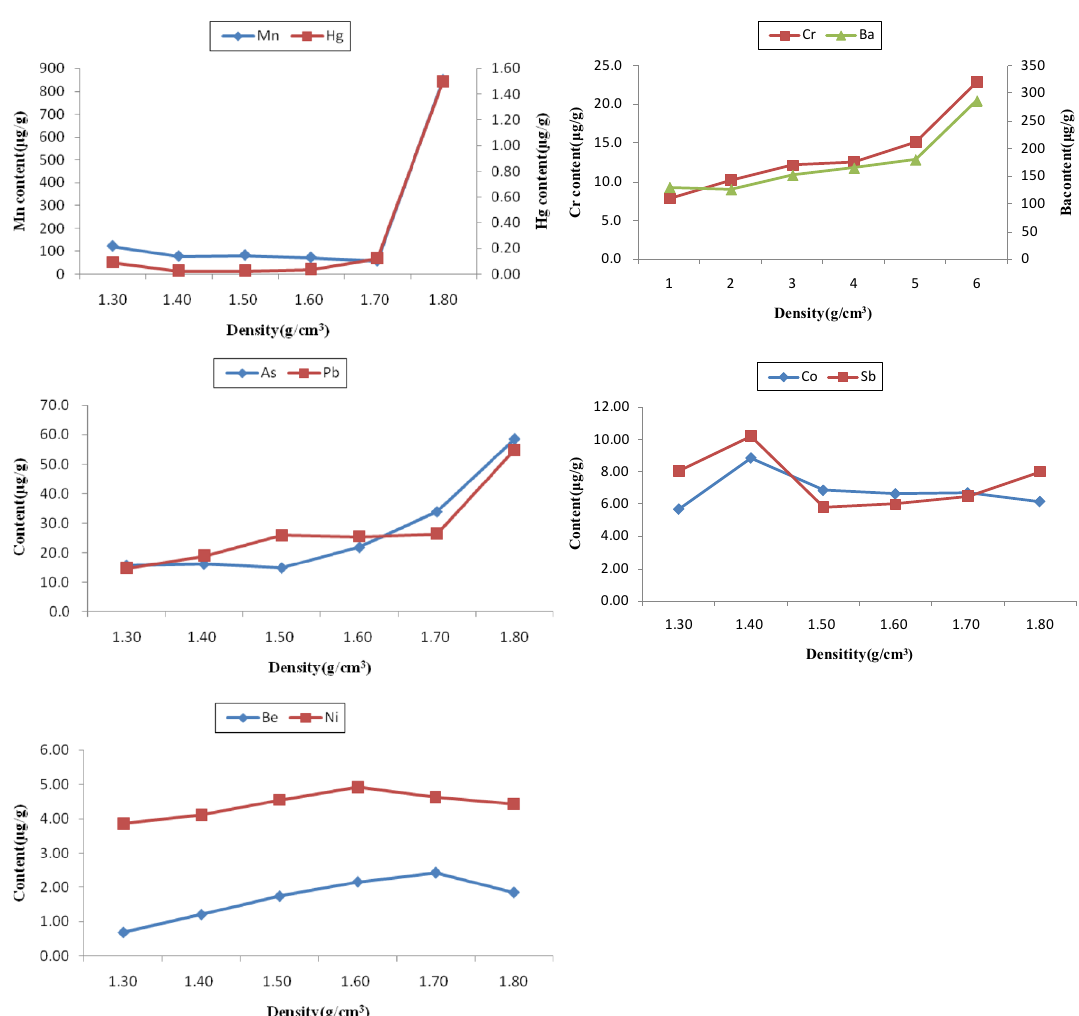
Fig. 7 Variations of trace element concentrations for the products of different densities of the No.14 coal in the Huolinhe